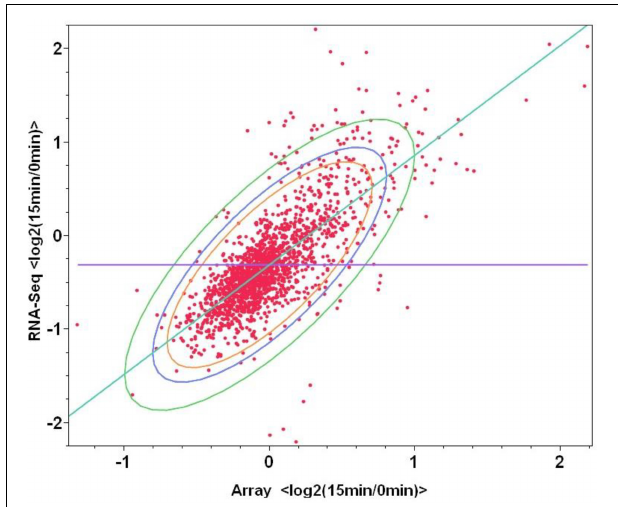
FIGURE 4 | Correlations between two transcriptomic approaches of microarray and mRNA-Seq for the genetic feature changes in response to furfural shock. The X -axis and Y -axis are the log 2 -based gene expression differences after 15 min post furfural shock using microarray and RNA-Seq